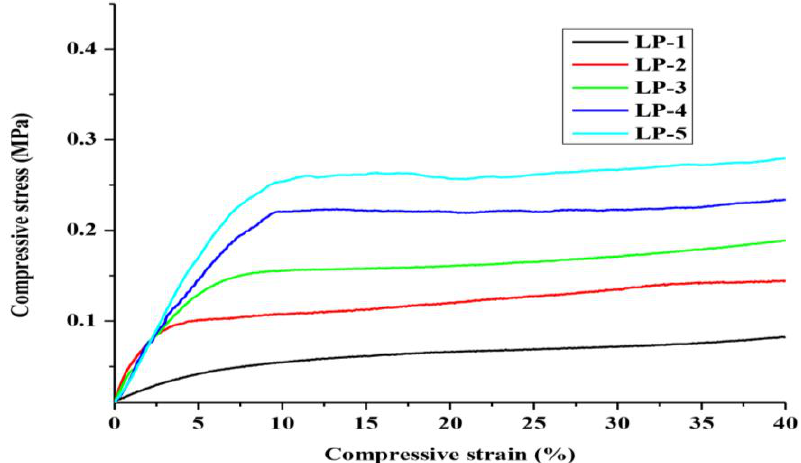
Figure 6. Mechanical properties of the rigid PU